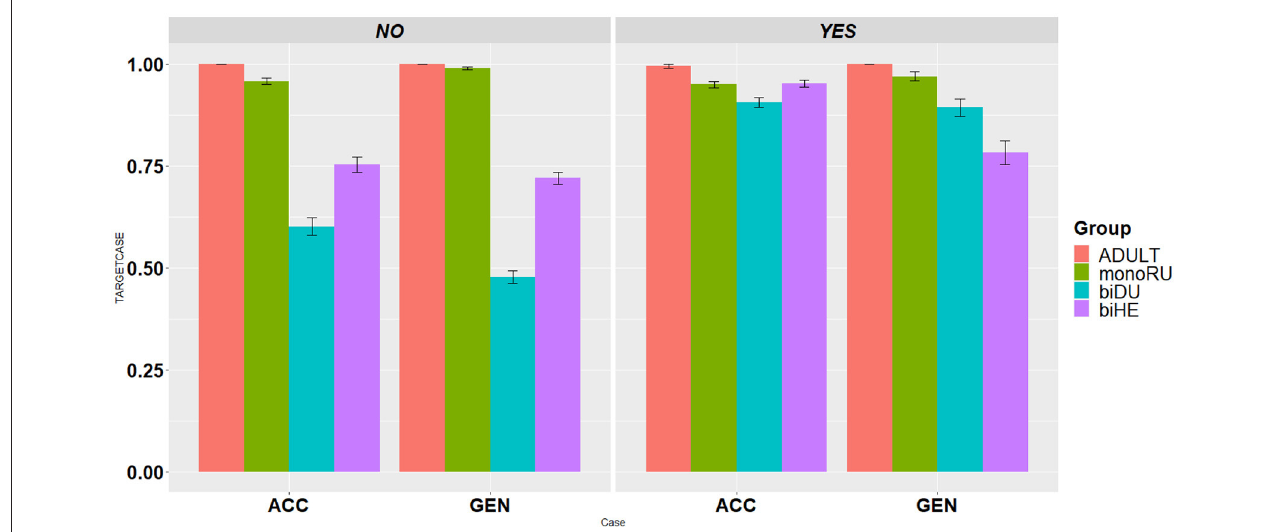
FIGURE 2 | Mean accuracy scores (with standard error bars) per case (ACC vs. NOM) per group (ADULT, monoRU, biDU, biHE) per inflection type (Homophonous to NOM: NO vs.